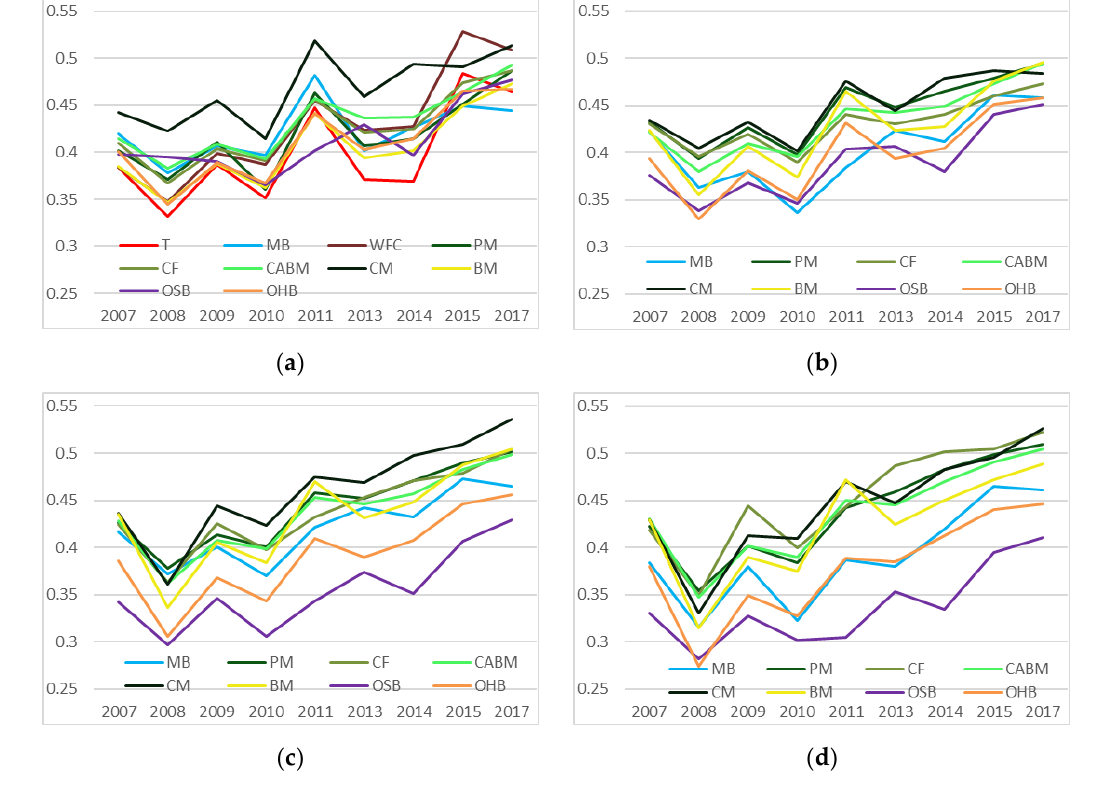
Figure 10. Broken-line graph showing EVI changes for 10 forest types, from 2007 to 2017, in four elevation zones: ( a ) 400–500 m; ( b ) 500–600 m; ( c ) 600–700 m; and ( d ) 700–800 m. Table 8. Disaster-impact-analysis results for different forest types in four elevation zones. Forest